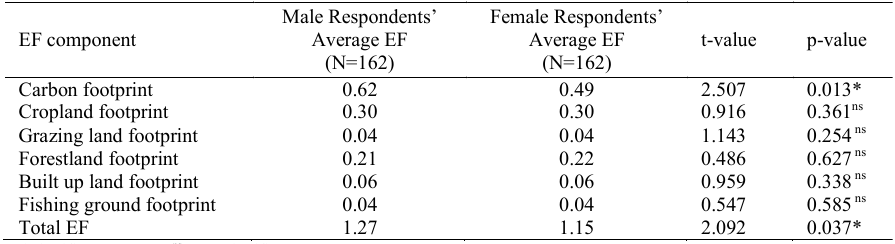
Table 2: Statistical comparison of ecological footprint between male and female respondents EF